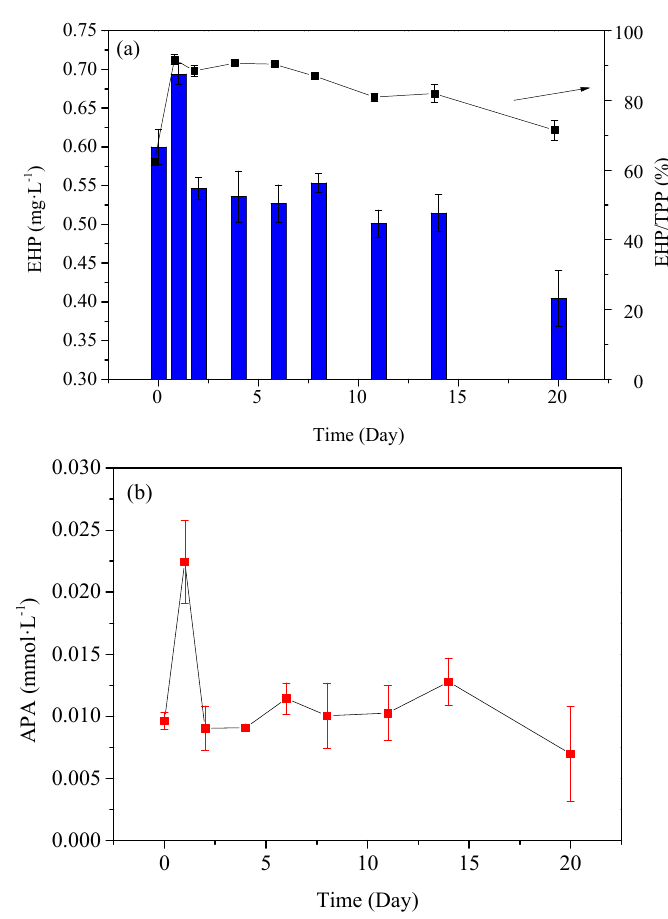
Figure 3. The content variation of Enzyme hydrolyzable P (EHP) and Alkaline phosphatase activity (APA) in PPOM. ( a ) The content variation of EHP and the ratio of EHP to total Particulate phosphorus (TPP), ( b ) the content variation of APA.